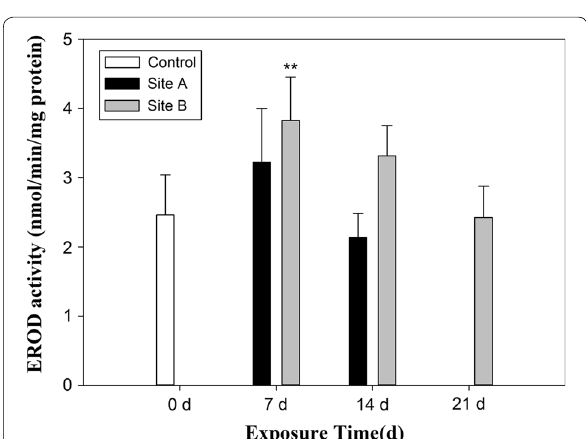
Fig. 3 EROD activities in the hepatopancreas of snails ( Bellamya aeruginosa ) caged at sites A and B over the duration of exposure experiments in Taihu Lake. Results are mean SD. Data represent the ± average of 30 individuals in each sample. Double asterisks indicate significant difference from the control ( P <